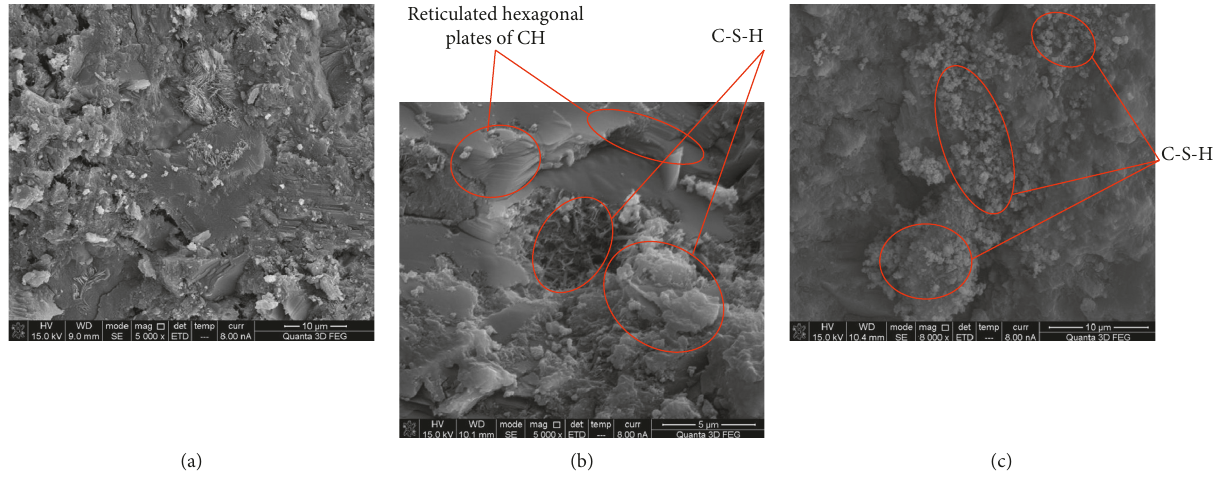
Figure 10: SEM at 90 days of (a) OPC, (b) CS30, and (c) SS30.